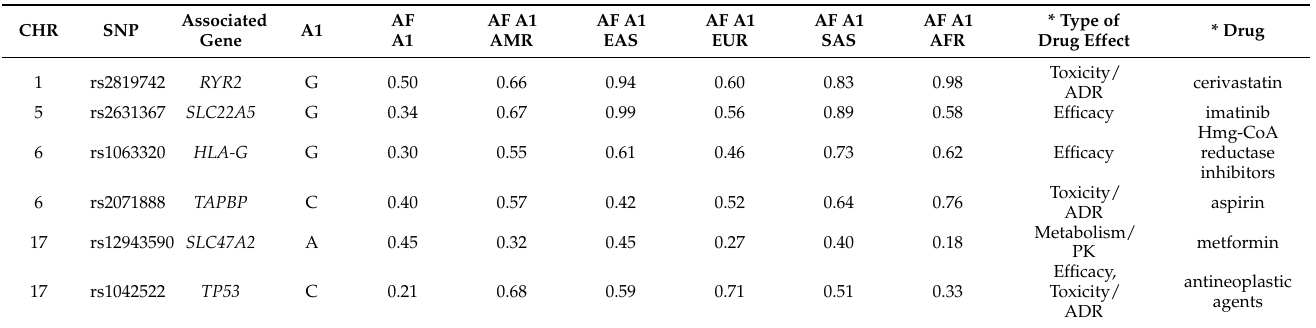
Table 1. Different frequency of pharmacogenetic variants in our Chilean population compared with all other world populations.